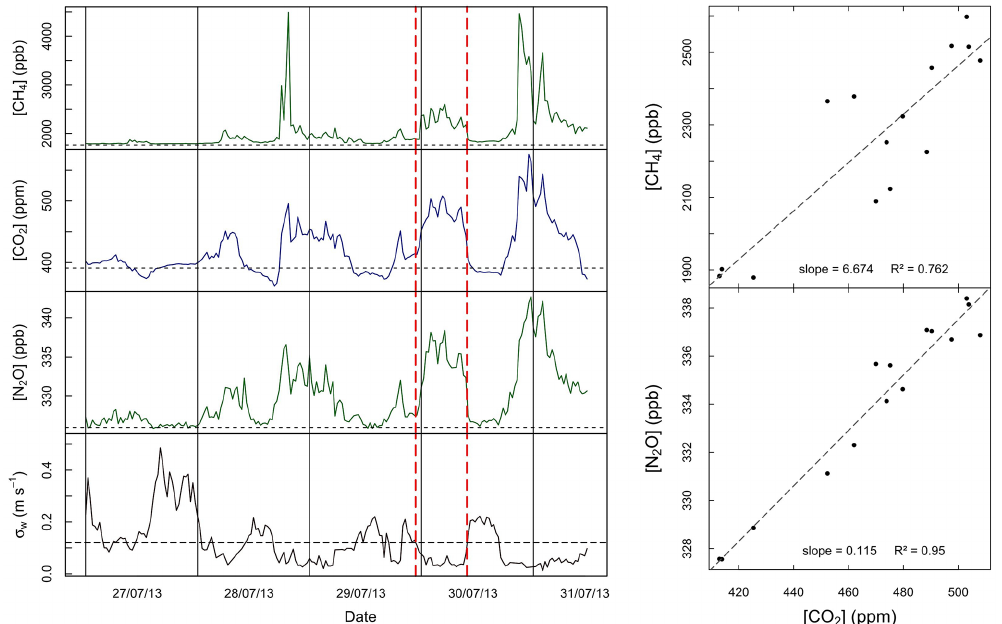
Figure 2. Left: evolution of CH 4 , CO 2 and N 2 O mole fractions (from top to bottom) at 0.76m height, as well as standard deviation of vertical wind speed ( σ w ) , at the IFR site, for a few days. Horizontal short-dashed lines indicate the Southern Hemisphere background values of the mole fractions. The horizontal long-dashed line marks the low-turbulence threshold for σ w . Vertical dashed lines enclose an example period of low turbulence. Right: linear regressions of mole fractions for CH 4 (top panel) and N 2 O (bottom panel) vs. that of CO 2 , for this example